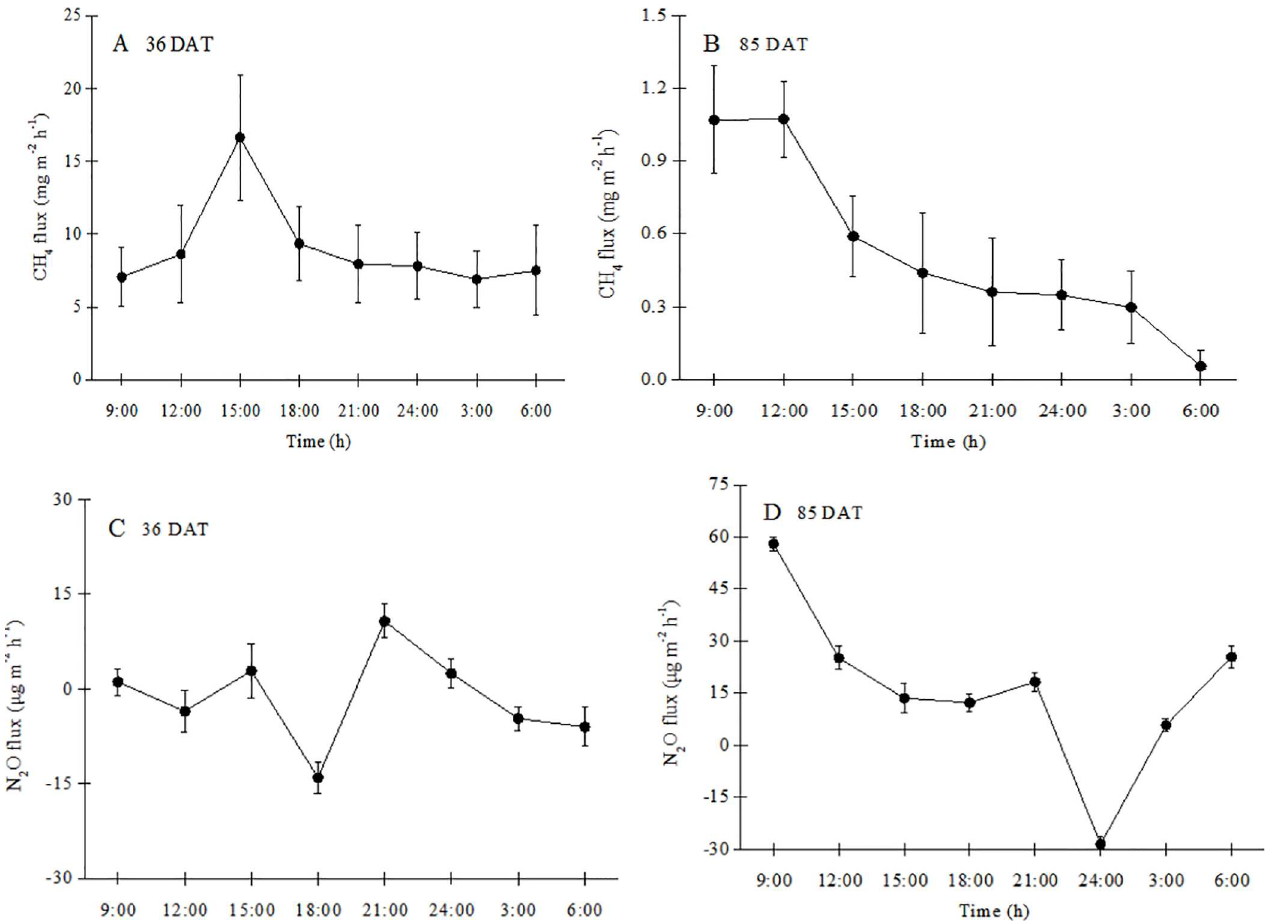
Fig 3. Diurnal variation of CH 4 fluxes in the paddy field 36 (A) and 85 (B) days after transplanting (DAT) and N 2 O fluxes in the paddy field 36 (C) and 85 (D) DAT. Error bars indicatethe standard error of the mean of triplicate